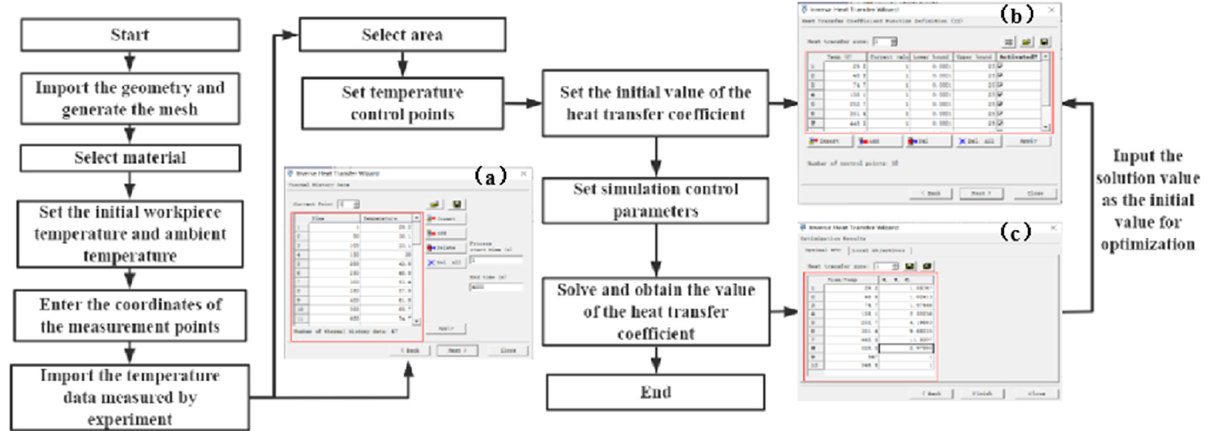
Figure 4. The process of solving the heat transfer coefficient in DEFORM. Table 4. The parameters of the simulation part.